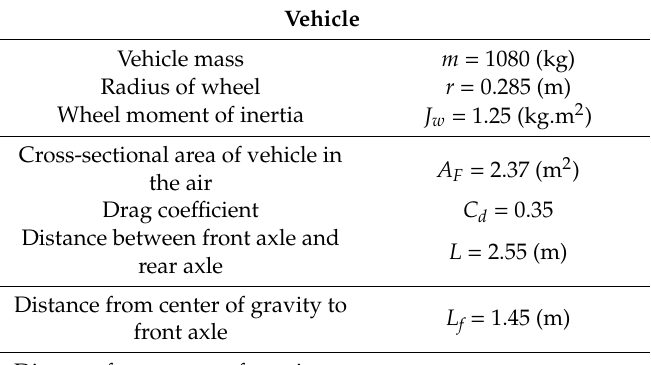
Table A1. Specification of the vehicle model.